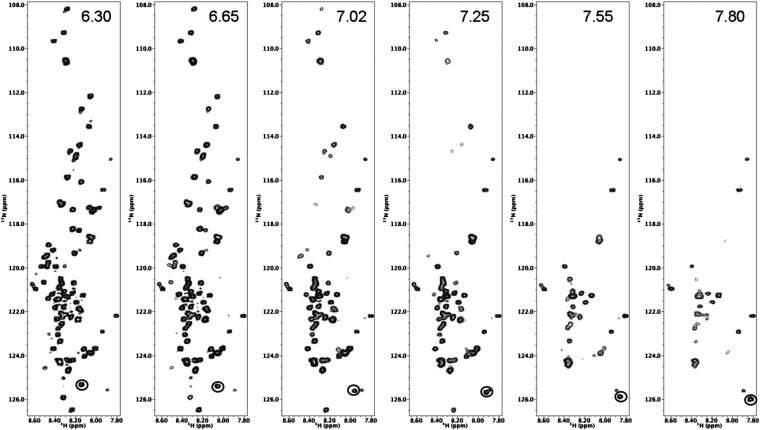
HSQC spectra of FSFG-K construct in buffer A vary with pH.HSQC spectra of FSFG-K in buffer A adjusted to the indicated pH's. In buffer, fast solvent exchange of significant number of peaks is apparent as expected (Croke et al., 2008, 2011; Burz et al., 2012). The His6 tag signal titrates with the pH change and is circled at the lower right of each panel.